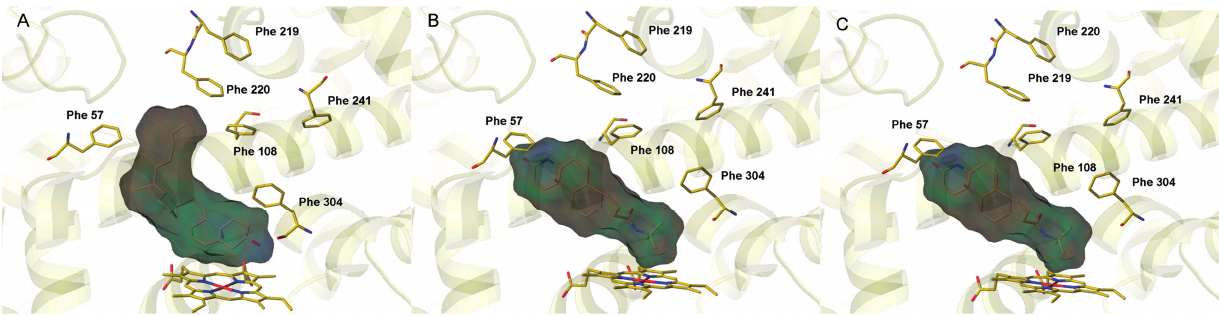
Figure 2. The binding modes of three typical substrates docked into the active cavity of CYP3A4 via lipophilic interactions with Phe-clusters or the heme. ( A ) Cholesterol; ( B ) finasteride; and ( C ) pregnenolone. The important residues interacting with the bound substrate in the CYP3A4 complex and a heme group are shown as yellow capped